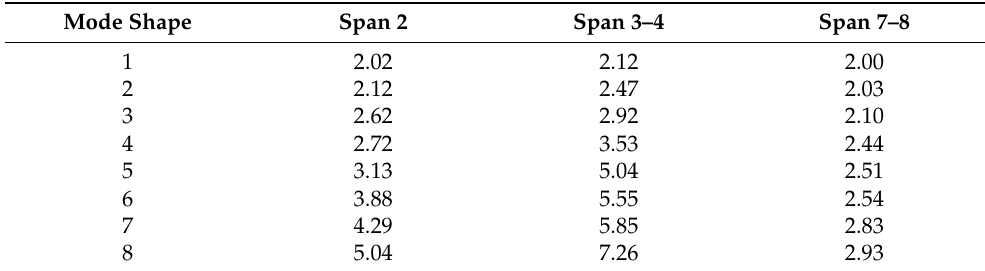
Table 3. Natural Frequencies of the first eight modes of vibration for Spans 2, 3–4 and 7–8 (accelerom-